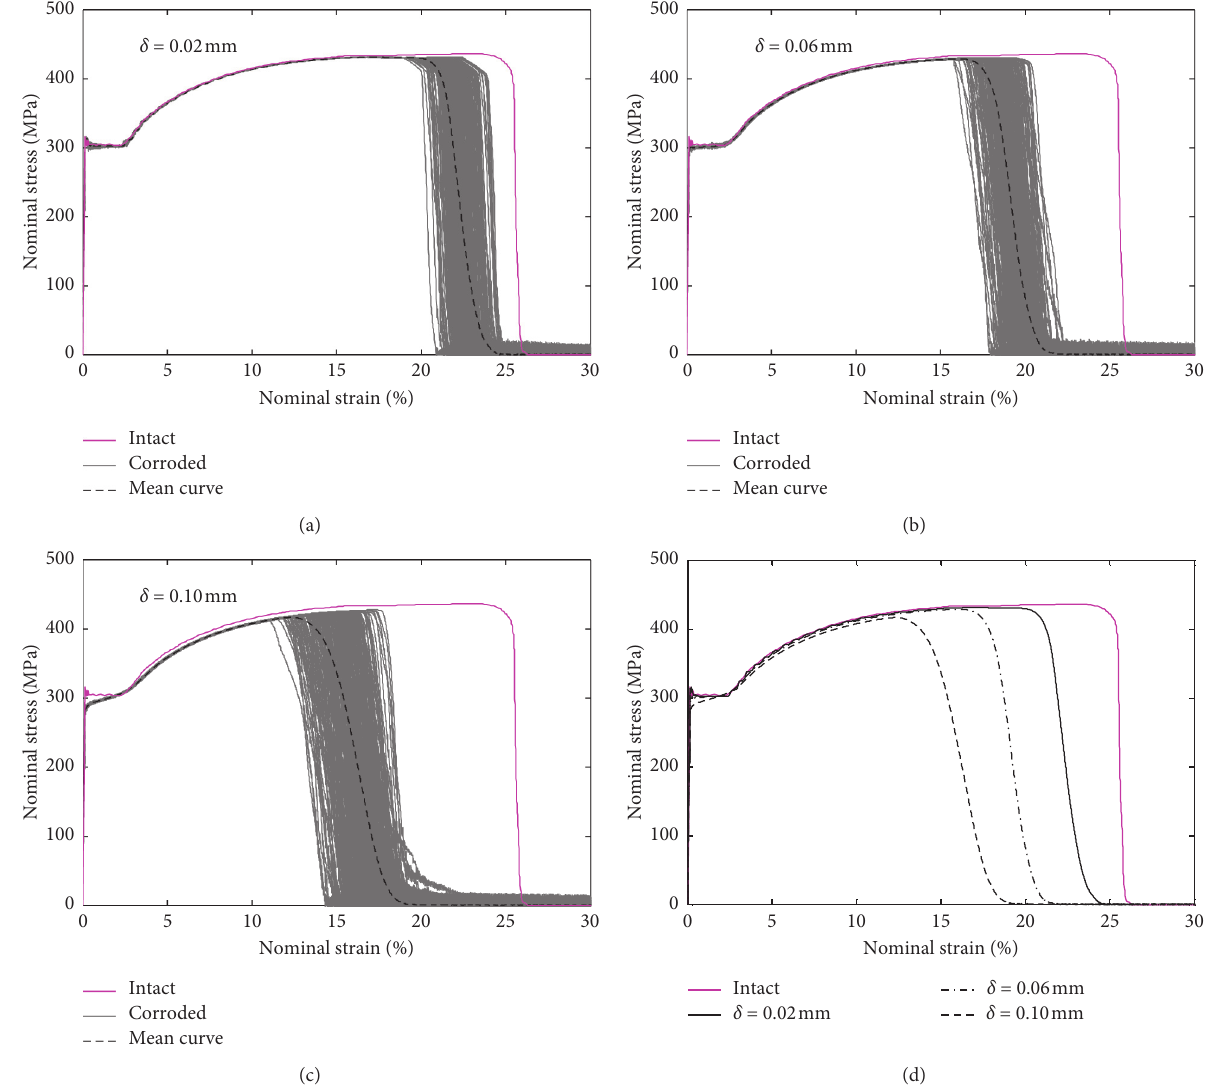
Figure 14: Stress-strain curves predicted using MCS with 300 samples ( η �